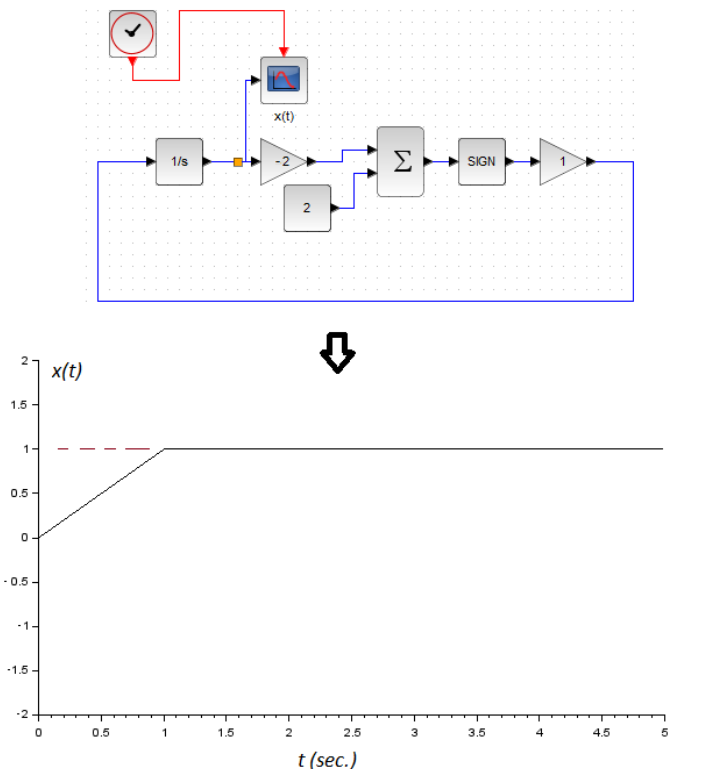
Figure 2. A numerical example using Xcos from Scilab application, where the numerical integration method used was RK 54. The concave function is f ( x ) = − ( x − 1 ) 2 . Note that the notation for the signum function sgn ( · ) in the Xcos environment is sign ( · )